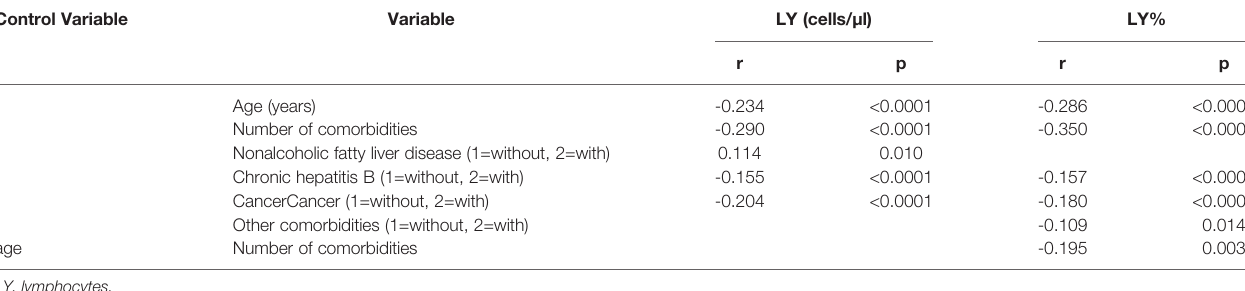
TABLE 2 | Spearman and partial correlation analysis of lymphocytes, age, sex, duration, geographical source of infection and comorbidities (n = 718). Control Variable